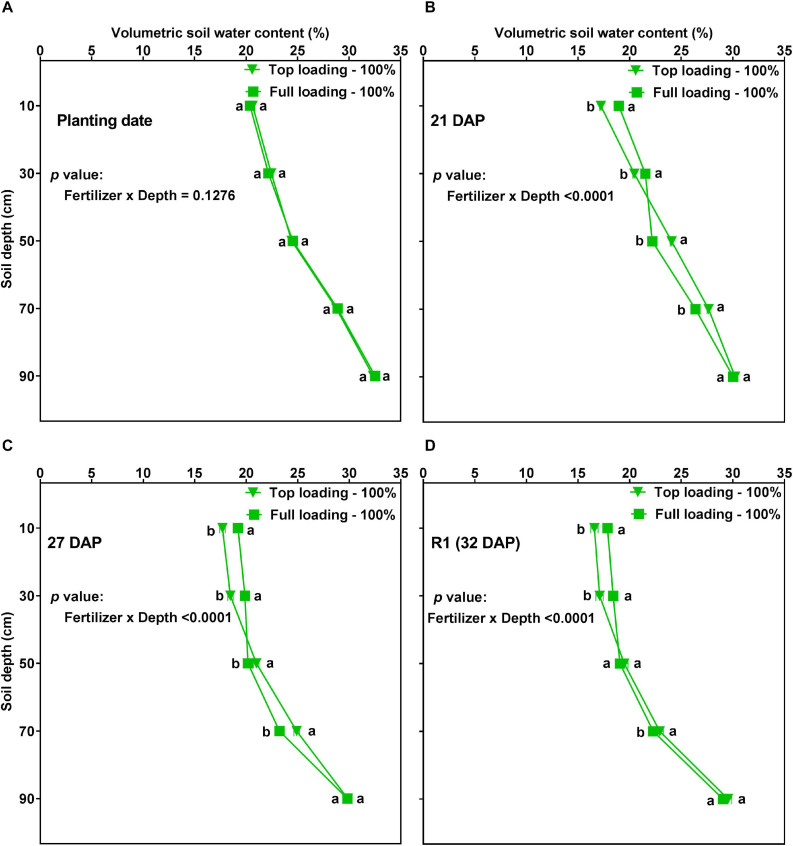
Volumetric soil water content (VSWC; %) by depth for soybean grown in a greenhouse in 1-m rooting columns under two fertilizer placement treatments [top loading (triangular symbols) or full loading (square symbols)] and watered daily to 100% soil water holding capacity. The VSWC measurements were taken 24 h after the previous watering. The measurements were made at planting date (A; top left), 21 days after planting (DAP) (B; top right), 27 DAP (C; bottom left), and 32 DAP (D; bottom right). Data represent the least square mean values of 15 plants ± 1 S.E. in each fertilizer placement treatment. Within a soil depth, values labeled with the same letter are not significantly different (p ≥ 0.05) according to a Tukey’s test. If not seen, the standard error is smaller than the symbol.